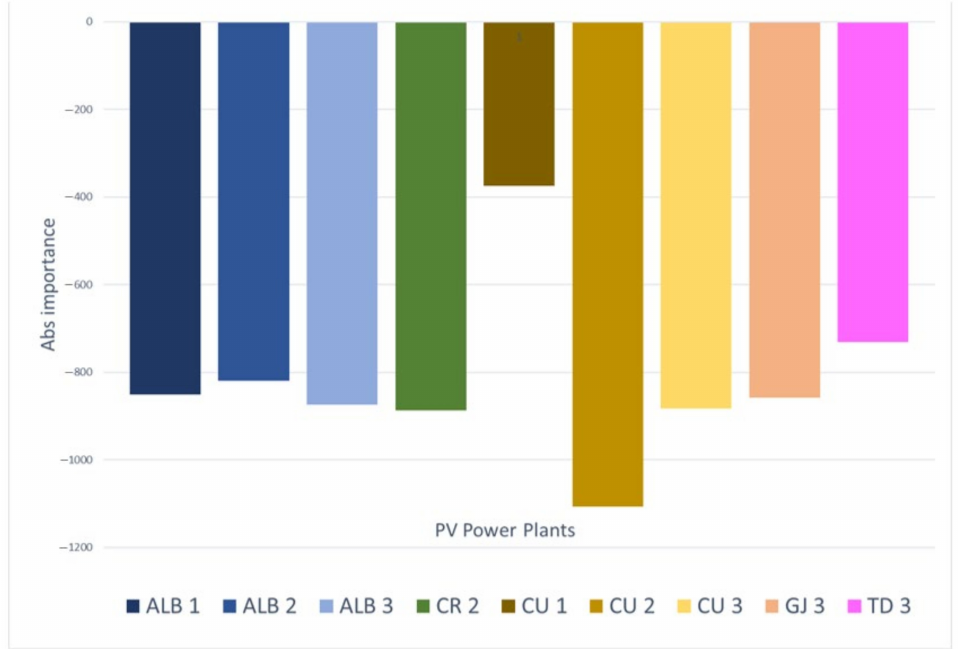
Figure 11. Representation of total absolute importance for different PV solar power plants in the construction